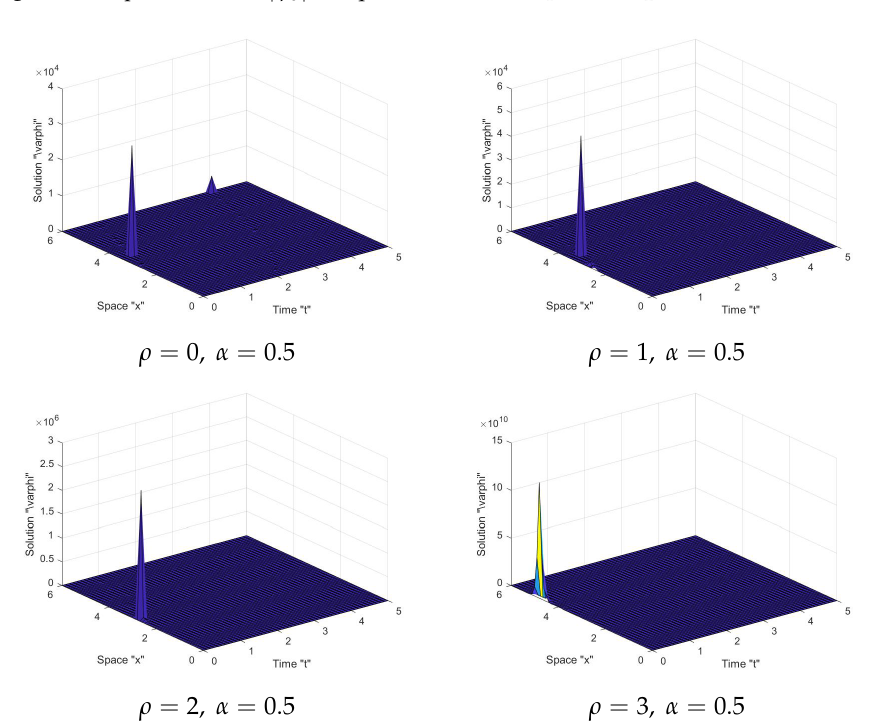
Figure 1. Graph of solution | ϕ 3 | in Equation (13) with ω 1 = − 1, ω 2 = − 1 and α = 1.